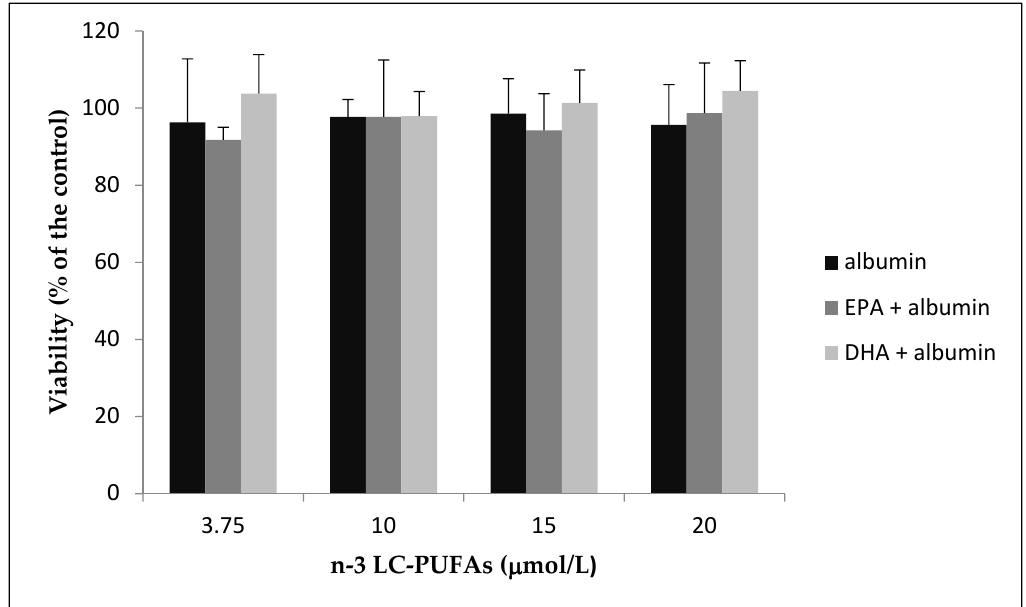
Figure 1. HMEC were incubated with increasing amounts of N-3 eicosapentaenoic acid (EPA) and docosahexaenoic acid (DHA) complexed with human defatted albumin or an equivalent amount of human defatted albumin (control) for 24 h. Viable cells were evaluated by MTT assay. Results from three separate experiments are shown as % of the control ± standard deviation.